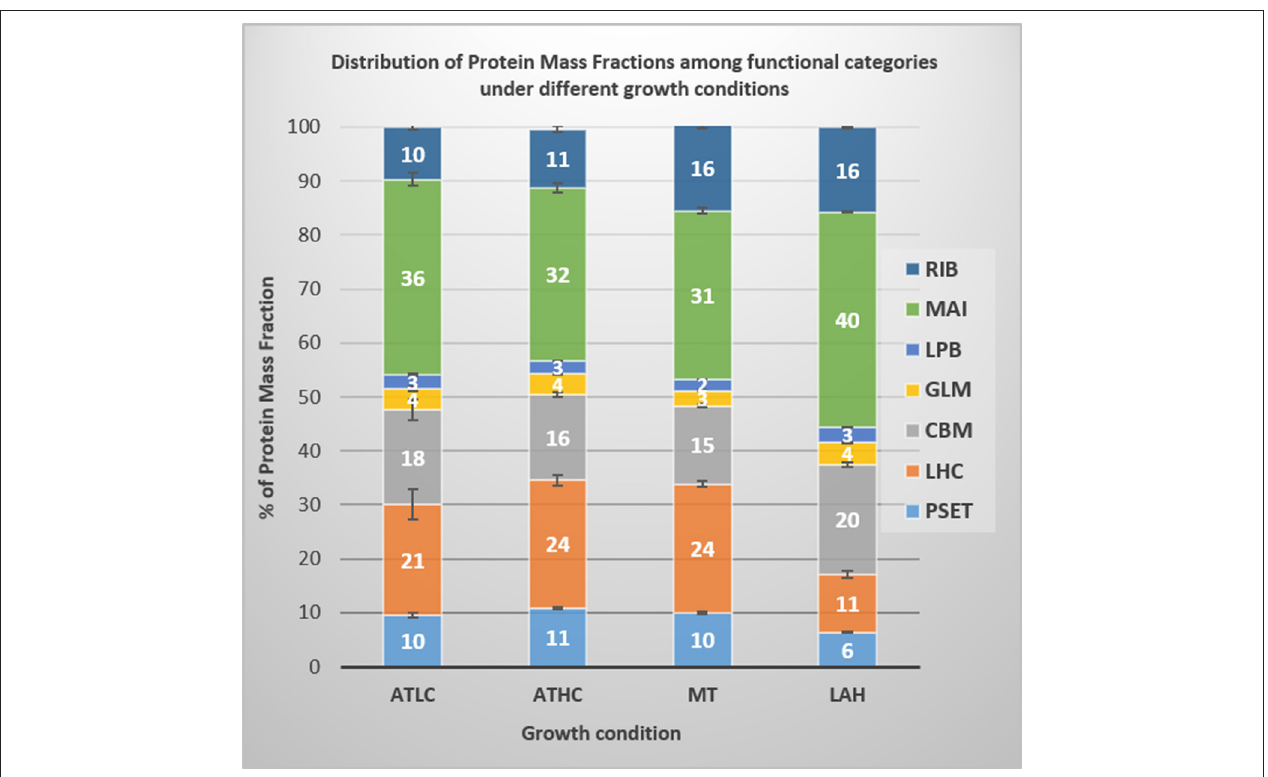
FIGURE 3 | Proteome mass fraction distribution into main categories in Synechocystis cells grown under the four different growth conditions, ATLC, ATHC, MT, and LAH. Functional categories: PSET, photosystems and photosynthetic transport; LHC, light-harvesting complex; CBM, carbon metabolism; GLM, glucose uptake and metabolism; LPB, lipid biosynthesis and membrane components; MAI, maintenance and regulation (including proteins of unknown function and hypothetical); RIB, ribosome and protein production. Three to four biological replicates per condition were used to calculate proteome mass fractions and corresponding standard